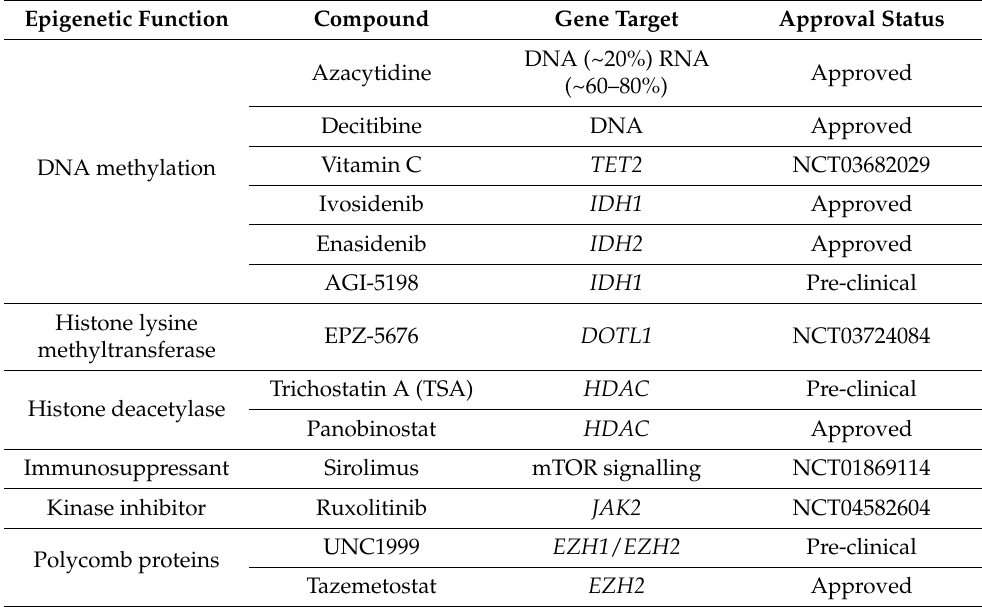
Table 1. Table showing overview of mentioned drugs currently in development or approved for treatment of myeloid malignancies via epigenetic